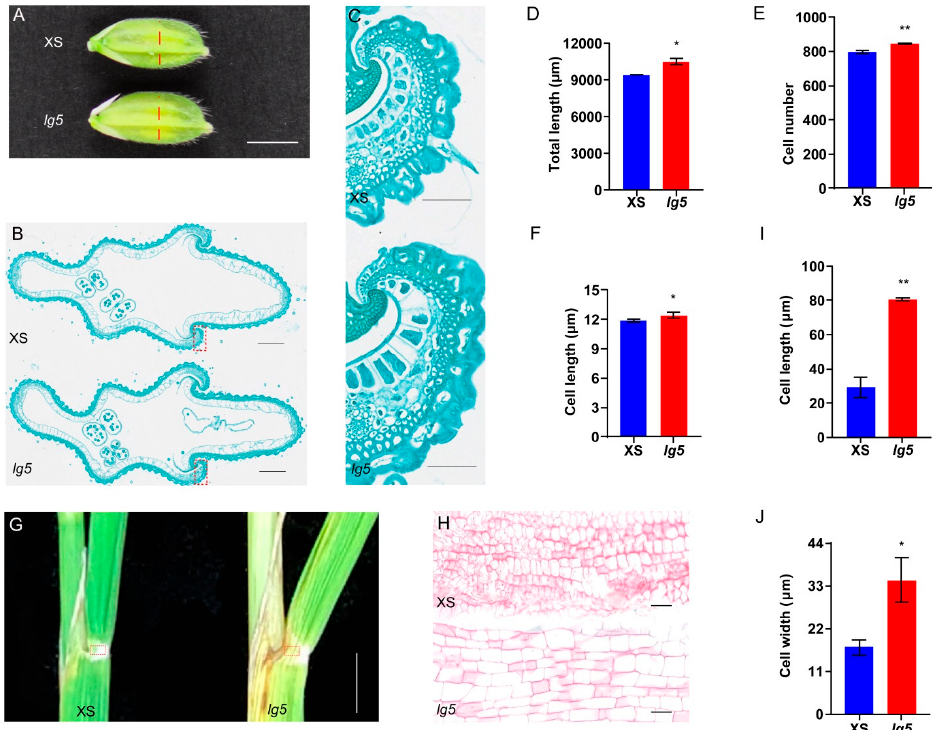
Figure 5. Paraffin sections of XS and lg5 . ( A ) Spikelet glume just before heading; bar = 3.4 mm. ( B ) Central parts of spikelet hulls of the line in ( A ); bar = 320 μ m. ( C ) Magnified views of the boxed areas of ( B ); bar = 60 μ m. ( D–F ) Total length, cell number, and cell length in the outer parenchyma layer of the spikelet hulls. ( G ) Comparison of leaf lamina joint; bar = 5 mm. ( H ) Magnified views of the boxed areas of ( G ); bar = 50 μ m. ( I,J ) Cell length and cell width of the leaf lamina joint. Data were presented as means ± SD. * and ** indicate p < 0.05 and p < 0.01, respectively, according to Student’s t -test.